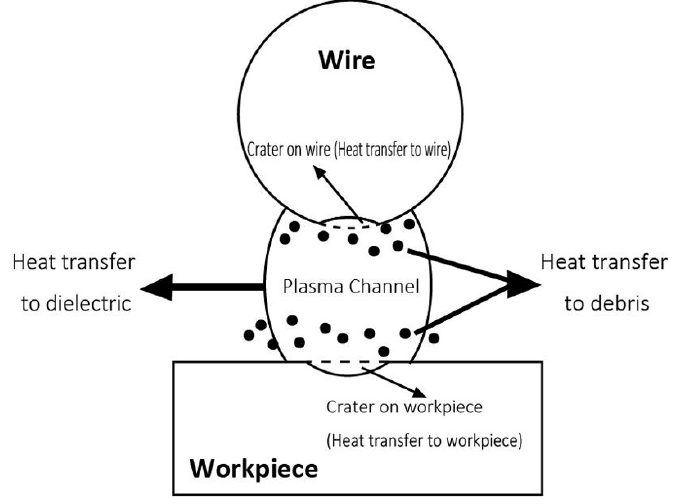
Figure 2. Heat transfer of plasma channel.